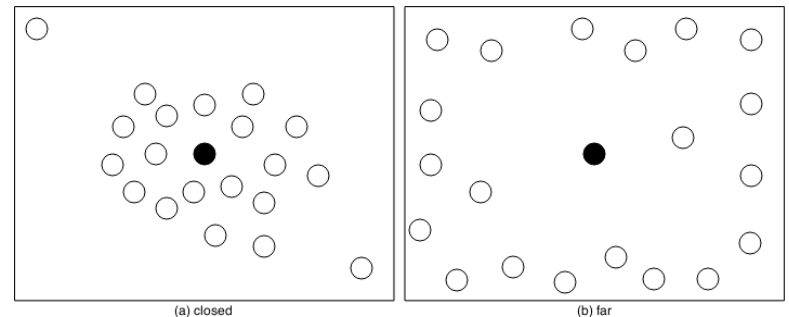
Figure 18. Sensor nodes are deployed ( a ) closed and ( b ) far from sink